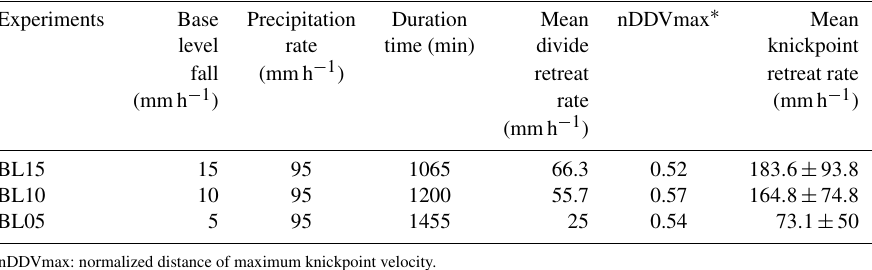
depends on the friction coefficient ( C ) that depends on wa- ter viscosity only for laminar flow; its theoretical value is ∼ 2 . 5 × 10 6 m − 1 s − 1 at 10 ◦ C (Baynes et al., 2018). To en- sure that Floodos outputs (e.g., water depth raster maps) cal- culated using this value are consistent with actual